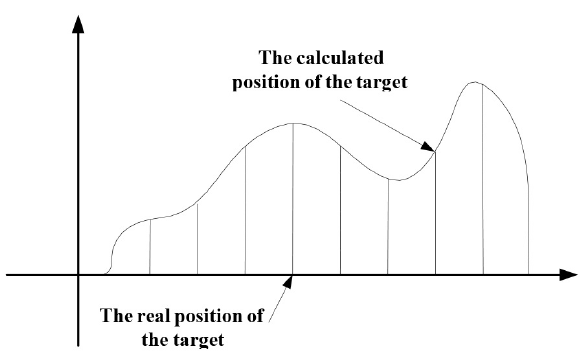
Fig. 2 The error in the target’s position